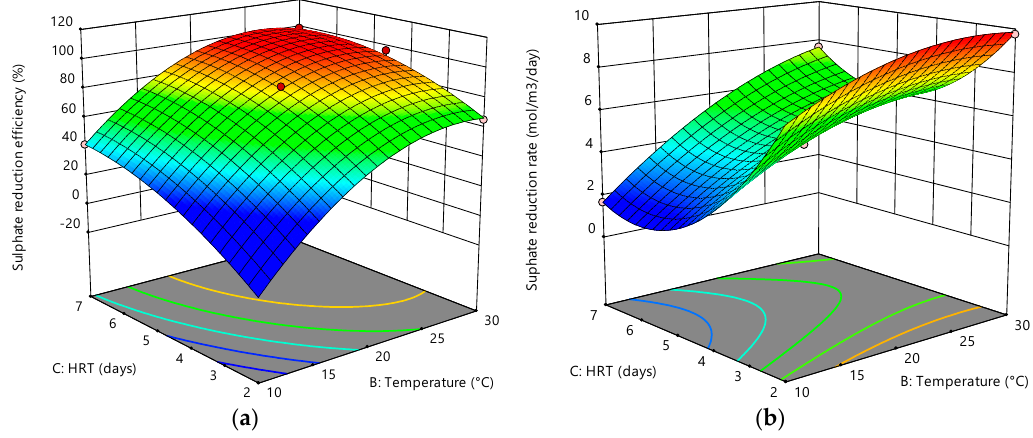
Figure 12. Interactive effects between HRT and temperature on ( a ) sulphate reduction efficiency and ( b ) sulphate reduction rate.